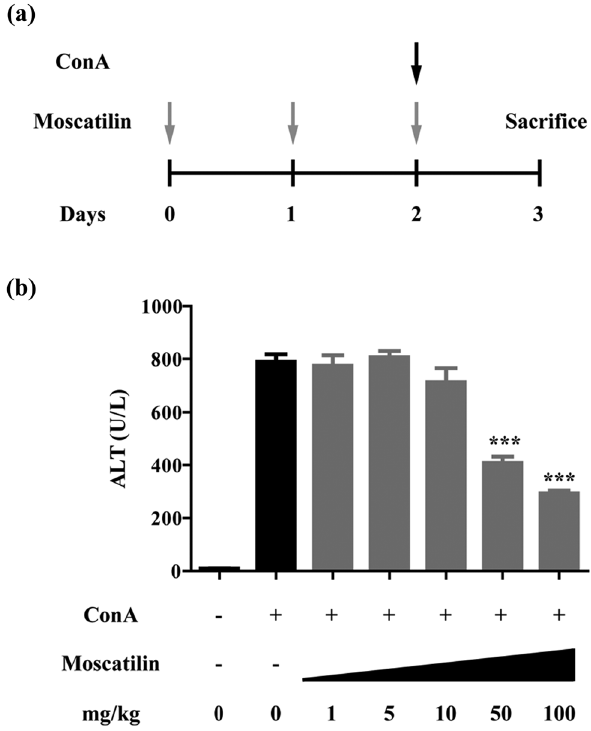
Figure 1: Moscatilin suppresses the ConA induced liver damage. ( a ) Schematic operation for the liver injury mice model. The mice received the di ff erent dose of moscatilin as indicated by intragas -